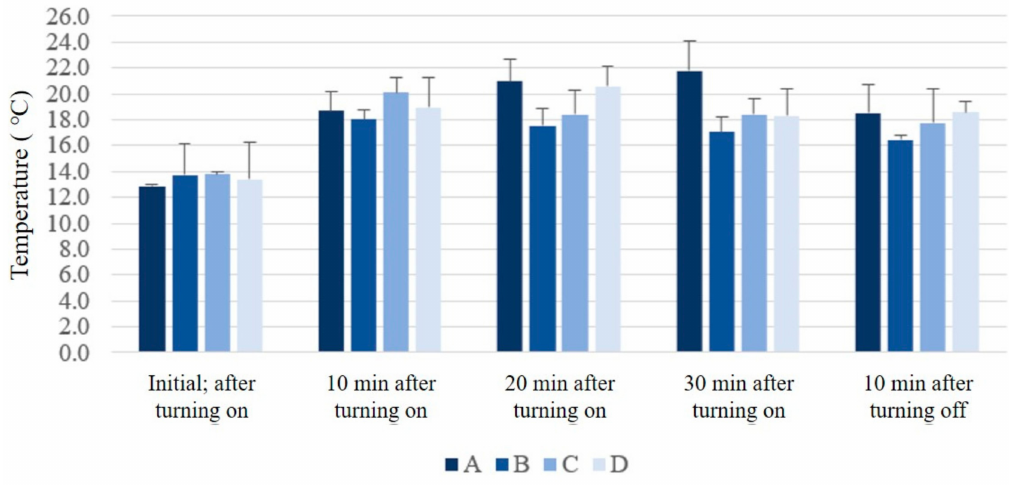
Figure 6. Surface temperature changes of the technical material samples according to exposure